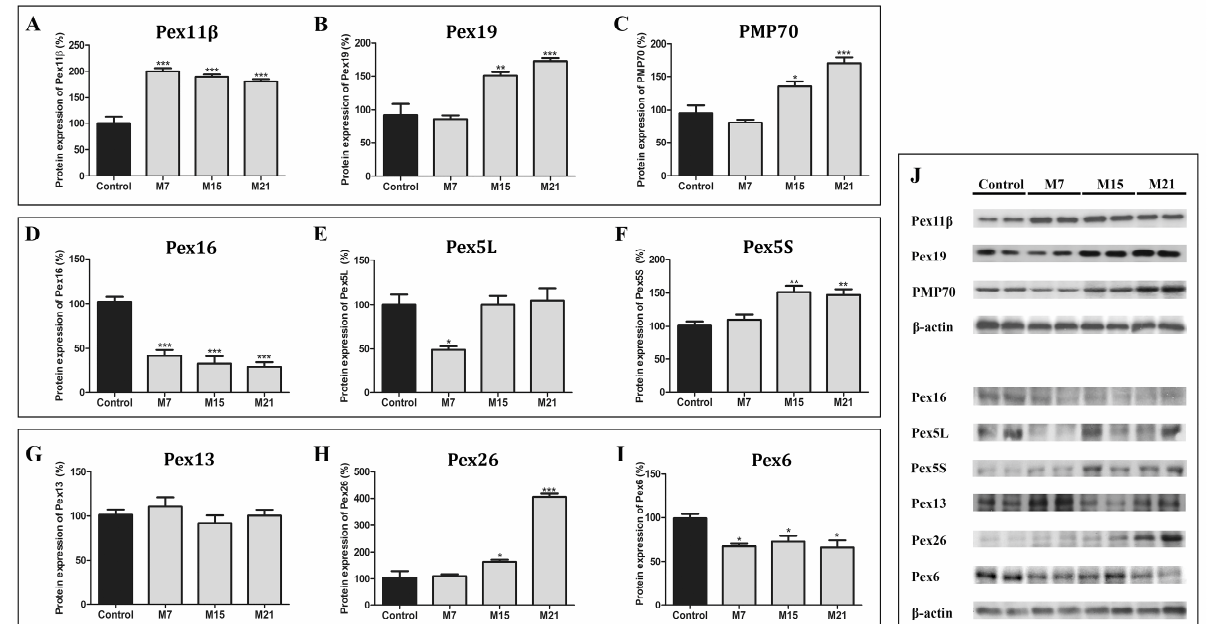
Figure 9. Protein expression of peroxins and PMP70 in rat brown adipose tissue of the euthyroid control (black) and hypothyroid groups (grey) treated with methimazole for 7 (M7), 15 (M15), and 21 (M21) days, respectively. Pex11 β ( A ), Pex19 ( B ), PMP70 ( C ), PEX16 ( D ), Pex5L ( E ), Pex5S ( F ), Pex13 ( G ), Pex26 ( H ), Pex6 ( I ). The protein content is expressed as a percentage of the control. Band images from a representative blot of three trials are shown ( J ). Bars represent the mean ± SEM. * Compared to control, * p < 0.05, ** p < 0.01, *** p < 0.001.